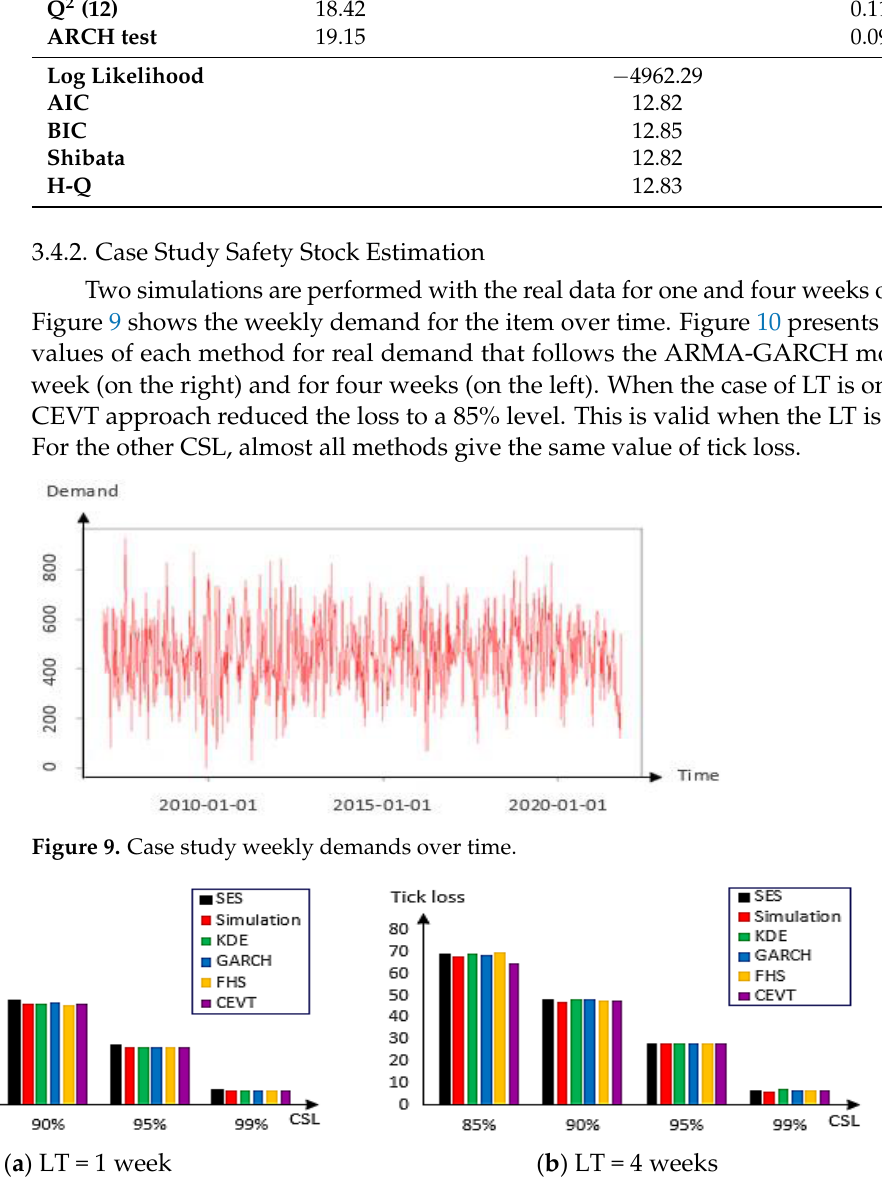
Figure 10. Tick loss values of each method for real demand that follows ARMA-GARCH model for one week ( a ) and for four weeks ( b ).